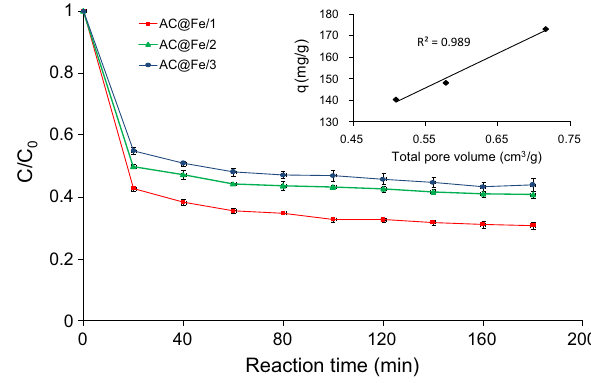
Fig. 5 Proportion of pore filling or blocking up (%) by the iron nanoparticles in the prepared heterogeneous catalysts AC@Fe/1, AC@Fe/2, AC@Fe/3 as a function of pore size range (ultrami- cropore Ø < 0.7 nm; supermicropore 0.7 nm < Ø < 2 nm; mesopore 2 nm < Ø < 50 nm) determined from the difference of the PSDs of each catalyst with respect of AC one